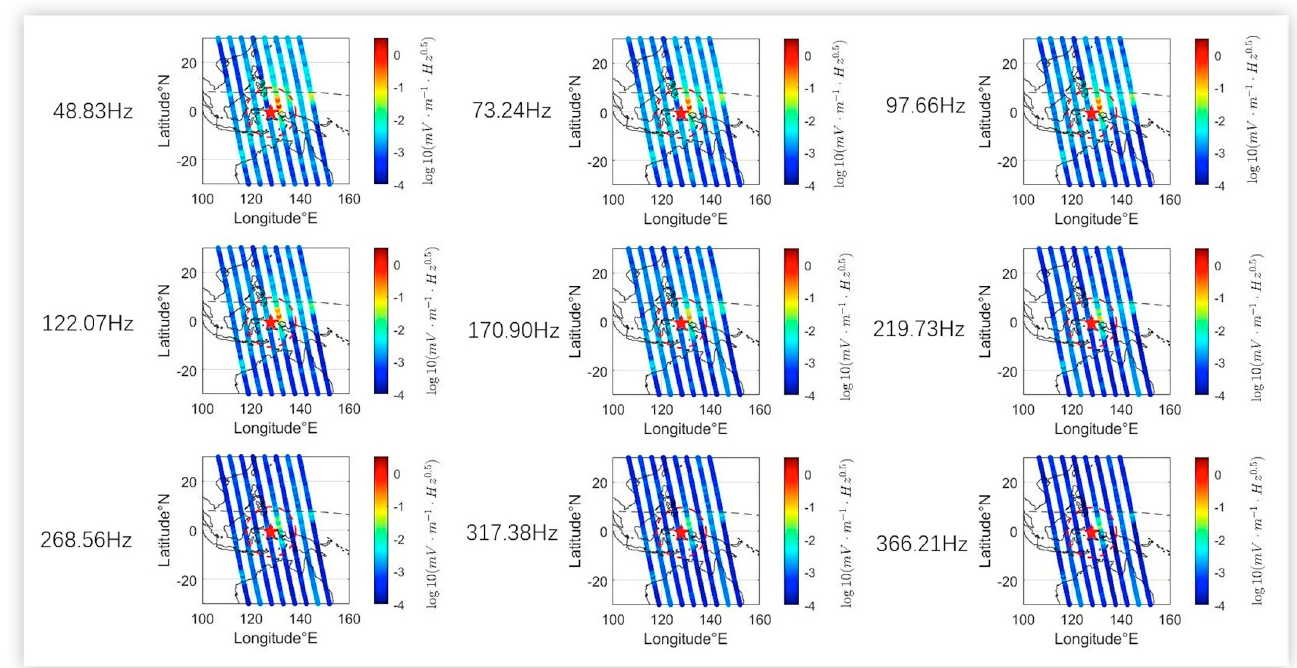
Figure 3. Similar to Figure 2, using the earthquake No. 2 as the object, the distribution of observational values of PSD of the electric field on the ascending orbits during 11 July to 15 July. From left to right, the dotted lines indicate the satellite trajectories on 13, 14, 15, 11, 12, 13, 14 and 15 July, respectively.